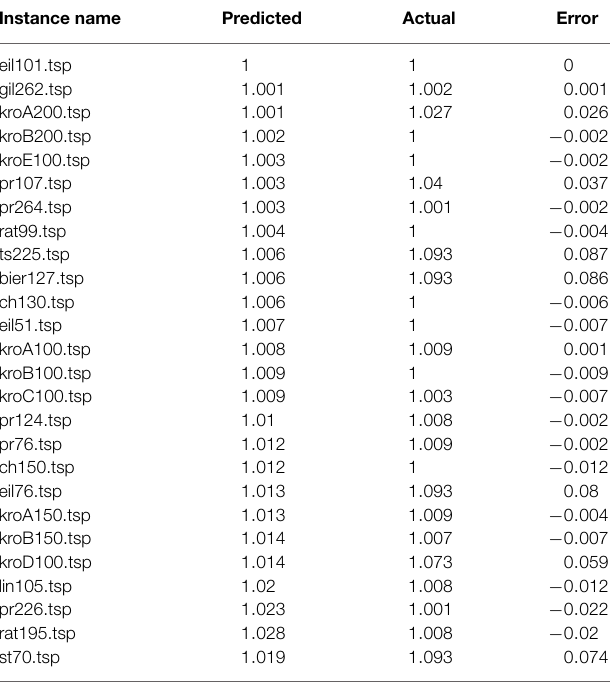
TABLE 3 | Predicted and actual parameter settings ( (cid:11) , (cid:12) , n , and (cid:26) ) for 26 TSPLIB instances of size in range 51–264 .